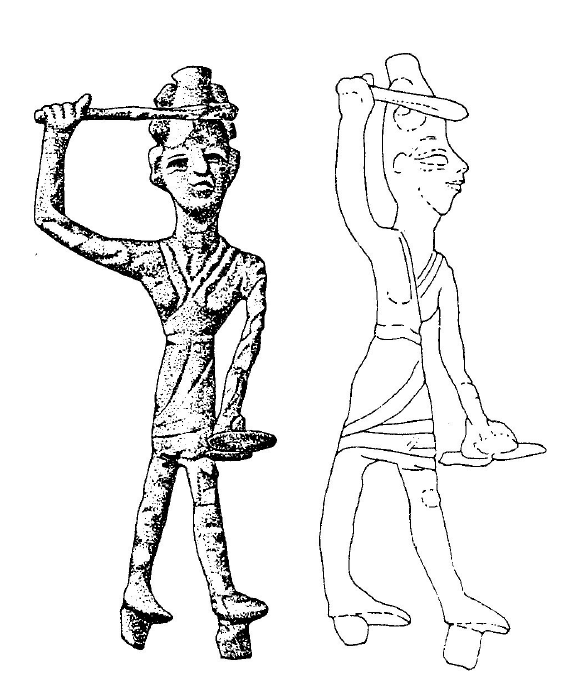
Figure 3 Bronze statue of the Baal type (Megiddo, Iron Age